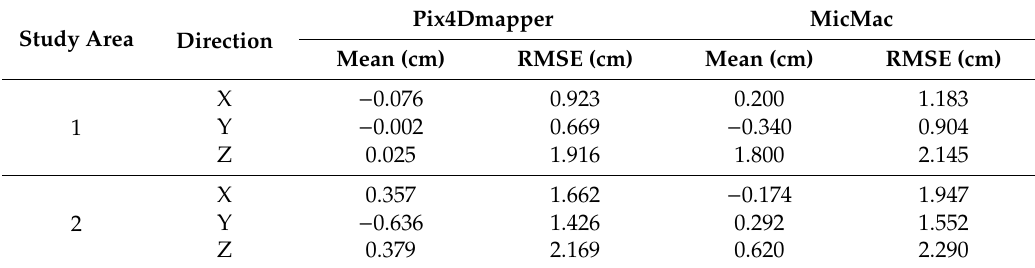
Table 1. Comparative results of photogrammetric processing in Pix4Dmapper Pro and MicMac in the two study areas.